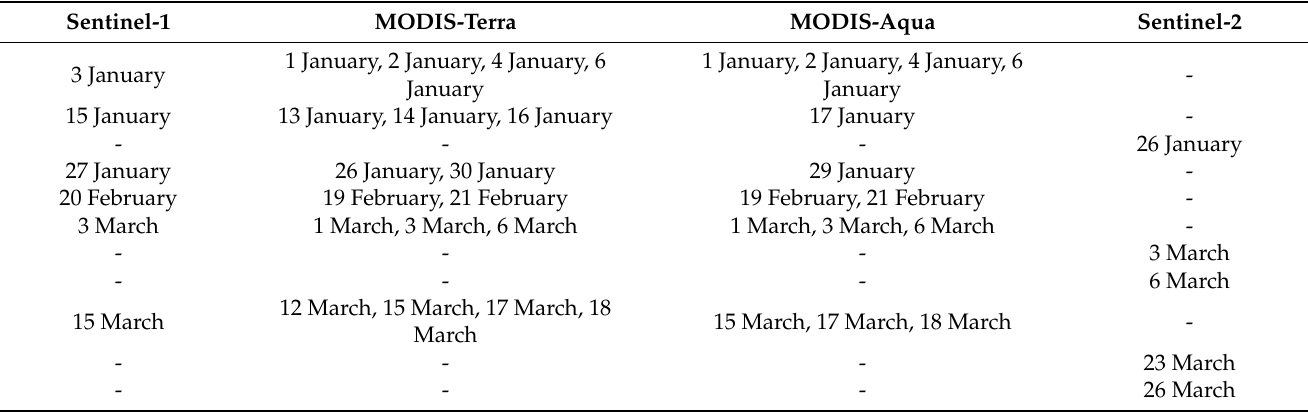
Table 6. Date information of the reference data.